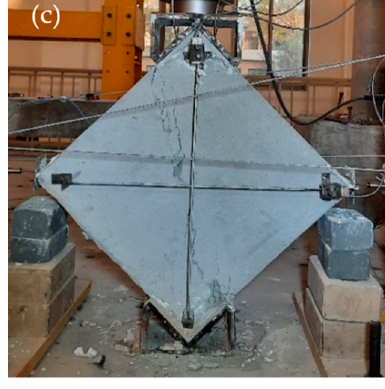
Figure 9. Failure patterns of PCD-reinforced wallets.